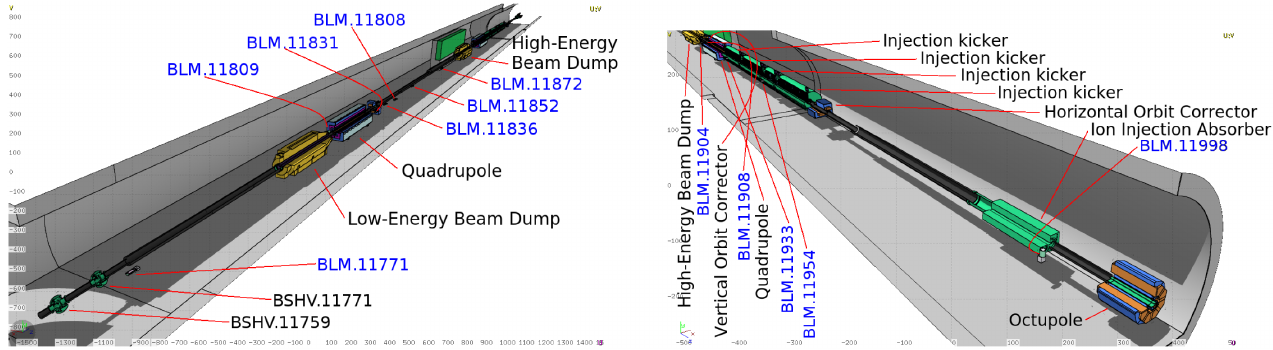
FIG. 17. 3D rendering obtained with the FLAIR geoviewer of the FLUKA geometry of LSS1: view from upstream (left frame) and from downstream (right frame). The beam travels from left to right. The scrapers are visible at the upstream edge of the upper frame. BLMs, despite not plainly visible in the geometry, are located usually at beam height. They are indicated as well, labeled in